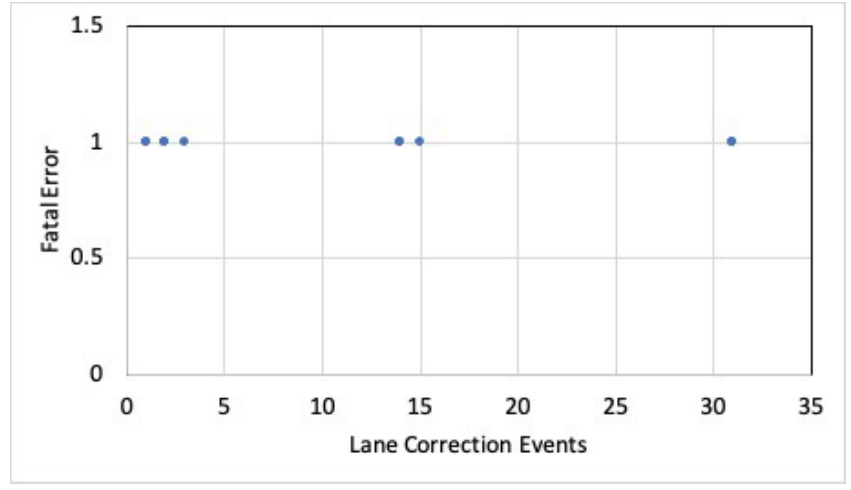
Figure 9. Fatal error vs. lane corrections events for test 8.0.1.